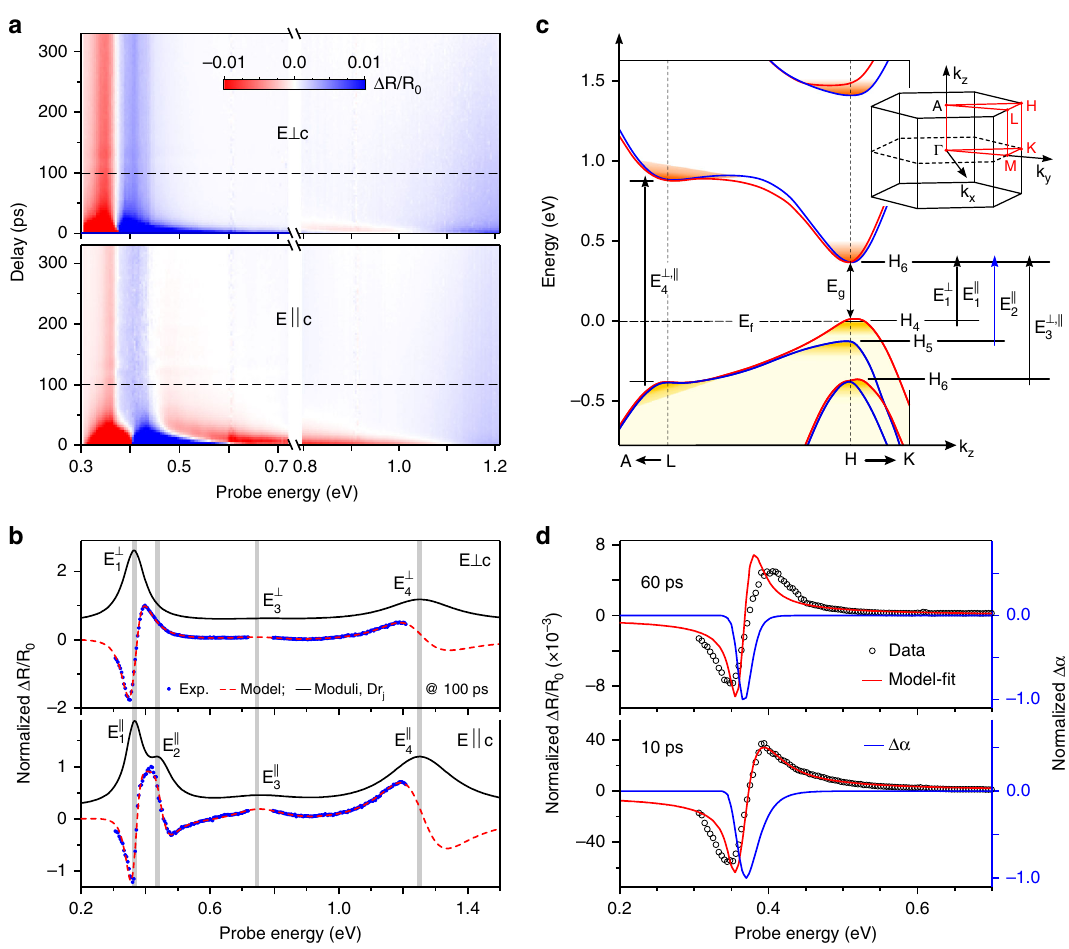
Fig. 2 Polarized spectral map and modeling of the TR response of a Te nanosheet. a Two-dimensional false color maps of the pump-probe delay dependent polarized TR spectra over extended probe energies, showing strong features with distinctive dynamics at different energies. b TR spectra (blue circles) acquired at a 100 ps time delay with two orthogonal probe polarizations. Each spectrum is fi tted with a simple model described in the main text (red dashed lines). Calculated moduli Δ ρ j of each fi t are also plotted with a vertical offset (black lines). Both the model fi ts and the moduli show transient features corresponding to the series of optical transitions in the Te bulk band structure. c Schematic band structure of bulk Te and possible optical transitions around the high symmetry H and L points of the Brillouin zone near the band-edge region. Observed transition energies in the TR spectra at different band-edge regions are indicated. On the top right, the fi rst Brillouin zone of Te and various high symmetry points are indicated. d Transient spectra (black open circles) around the fundamental gap region measured with the E ? c con fi guration of the probe pulse at two different time delays. Each spectrum is well reproduced using a band- fi lling model described in the main text (red lines). The calculated change in absorption Δ α , normalized by the peak values for clarity, at respective delay times are also superimposed with scales on the right (blue lines). Overall, the model captures the main features of the spectra and extracts important band parameters such as band gap and Fermi